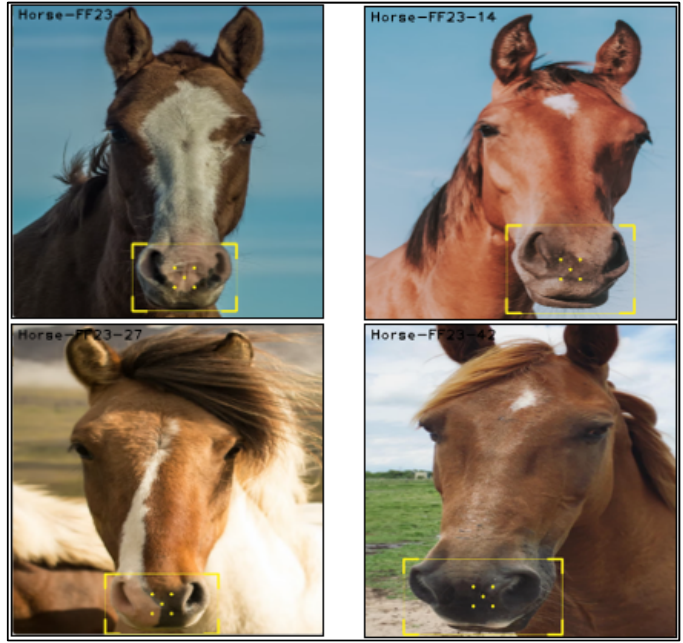
Figure 13. Examples of Successfully Identified Horses.